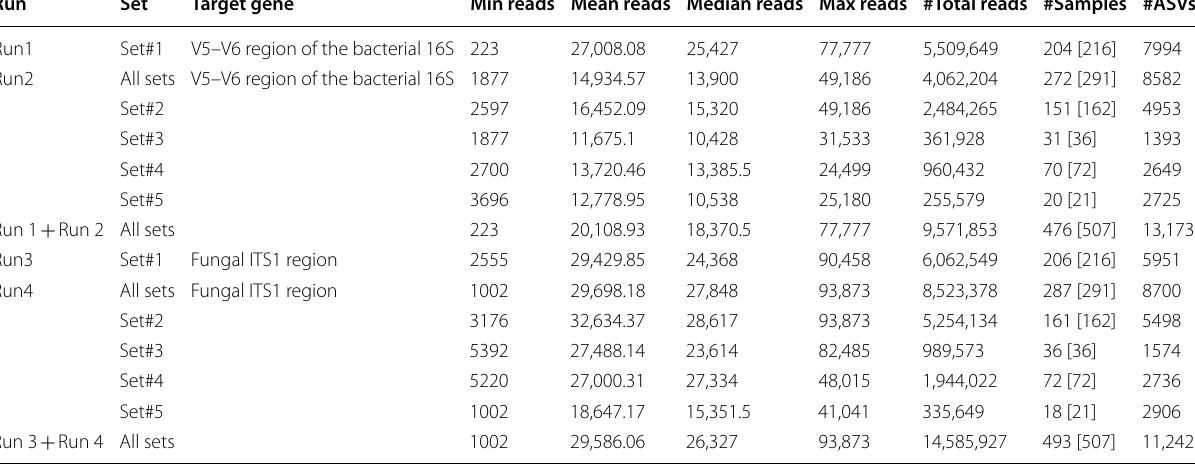
Table 1 Description of the Illumina MiSeq seqencing runs and the sequence data sets (Set#1 to Set#5 represented in Fig. 1C). For each data set, the table includes minimum (min), maximum (max), mean, median and total number of microbial reads per sample, and number of samples and Amplicon Sequence Variants (ASVs) after all quality filters. The total number of samples before quality filters is given into